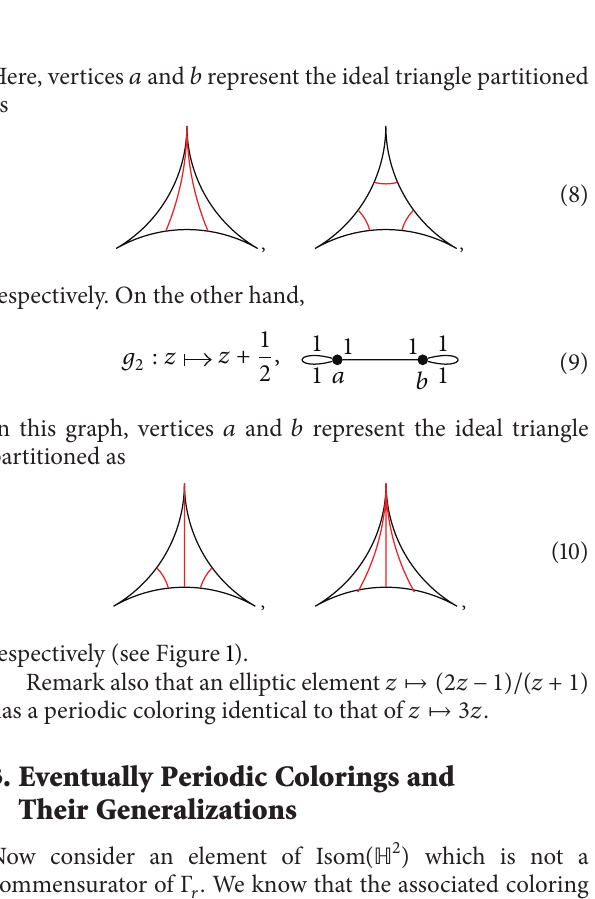
Figure 1: Examples of isometry 𝑔 associated with periodic